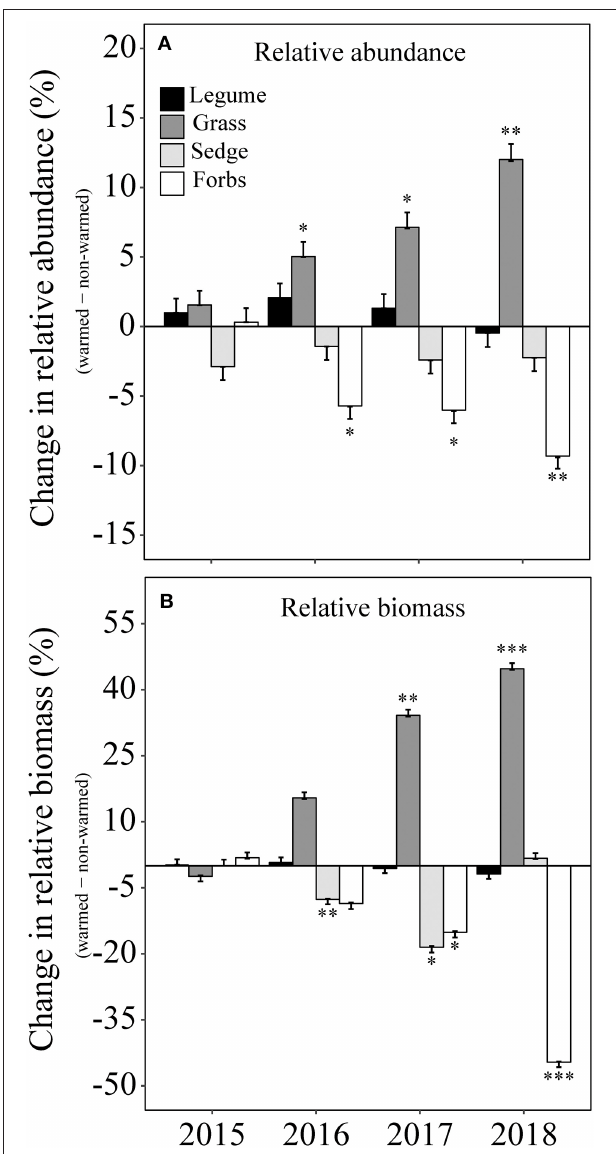
FIGURE 4 | Difference in relative abundance (A) and relative biomass (B) between non-warmed and warmed chambers for each functional type (i.e., Legume, Grass, Sedge, and Forbs) from 2015 to 2018. Positive and negative values indicate an increase or a decrease in the warmed chambers. * P < 0.05; ** P < 0.01; *** P <